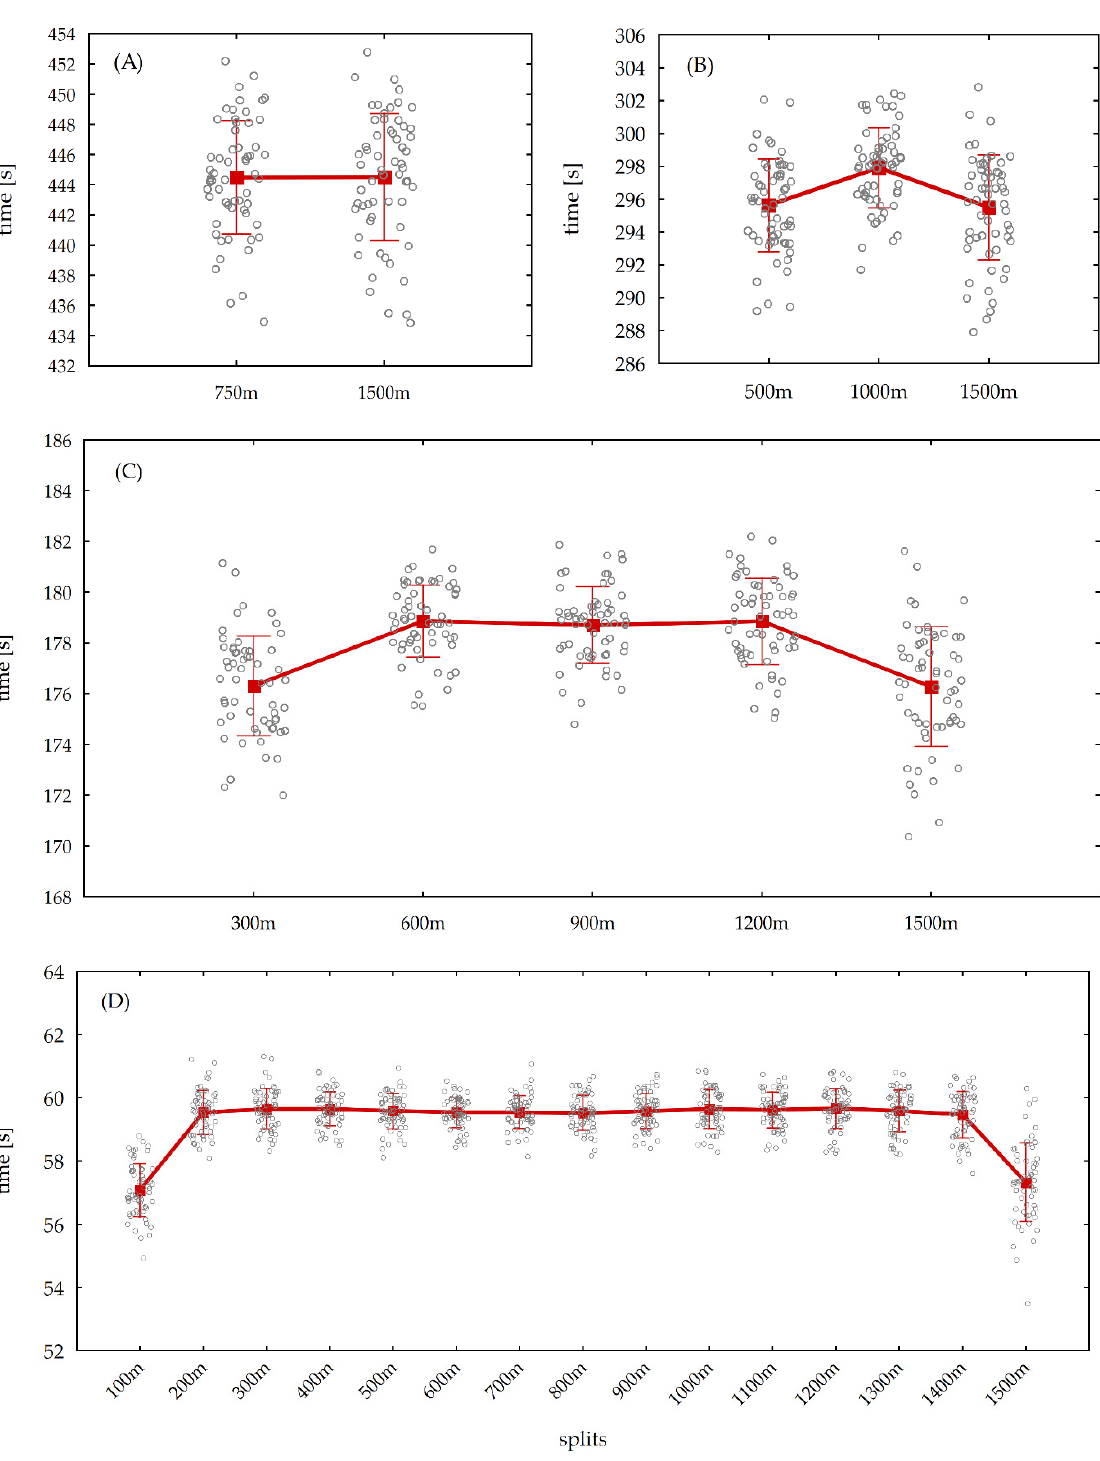
Figure 1. Mean and standard deviation of the ( A ) 750 m, ( B ) 500 m, ( C ) 300 m, and ( D ) 100 m splits in the pace distribution among the 60 all-time best competitors in 1500 m male freestyle long-course (50 m) swimming.